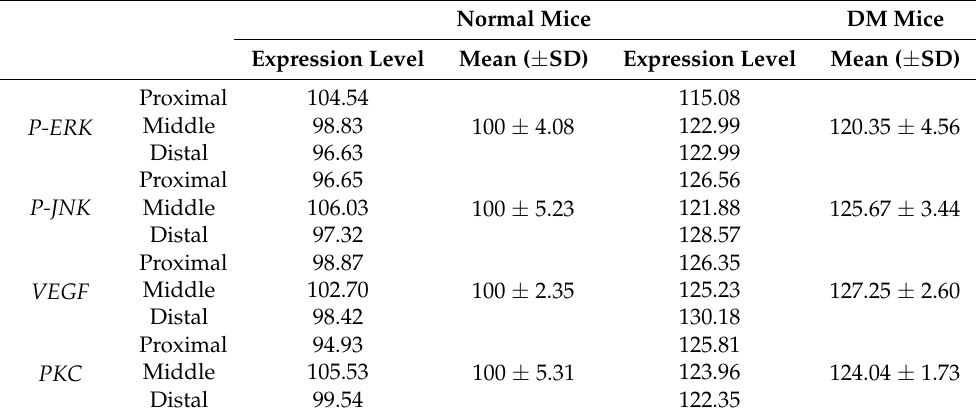
Table 1. The comparative experimental values of P-ERK, P-JNK, VEGF, and PKC between the normal and diabetic